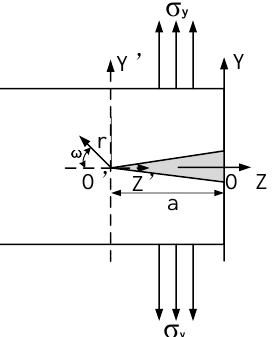
Figure 2. Schematic diagram of the crack model.